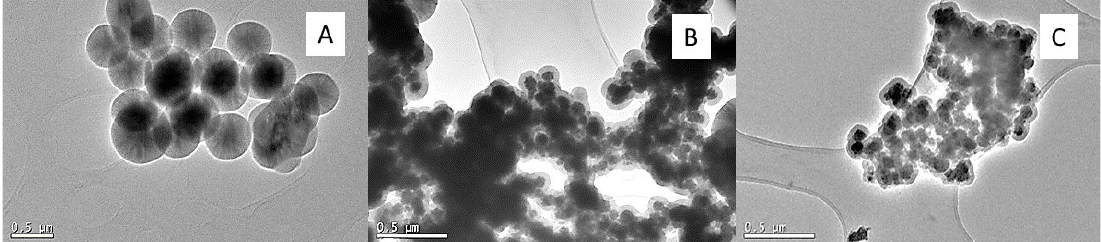
Figure 4. Transmission micrographs of Fe 3 O 4 @SiO 2 method C; ( A ) magnetic core coprecipitation; ( B ) magnetic core via solvothermal; ( C ) magnetic core dilution via solvothermal.